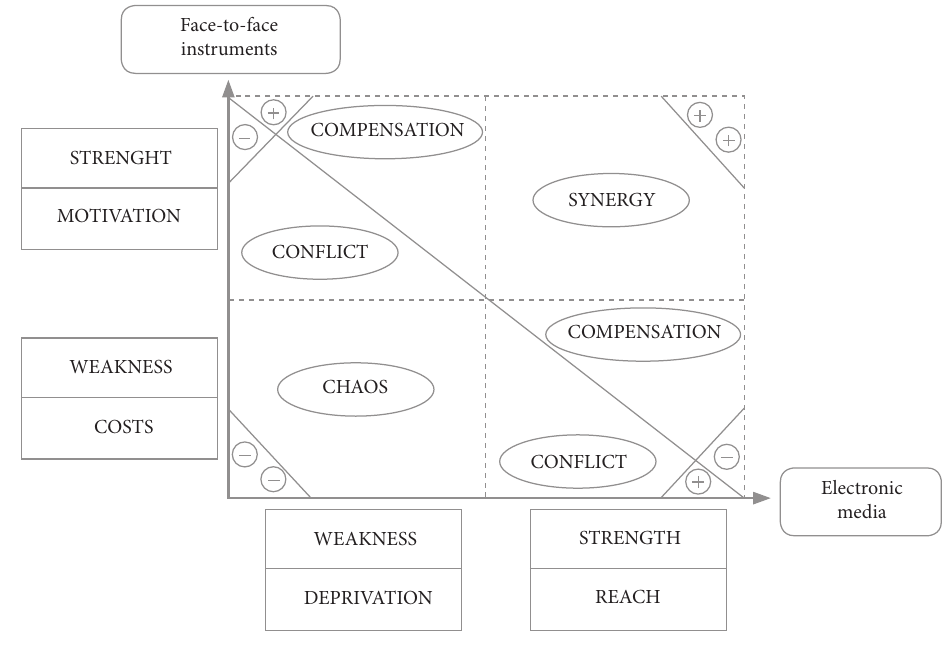
fig. 1. Evaluation model for hybrid media